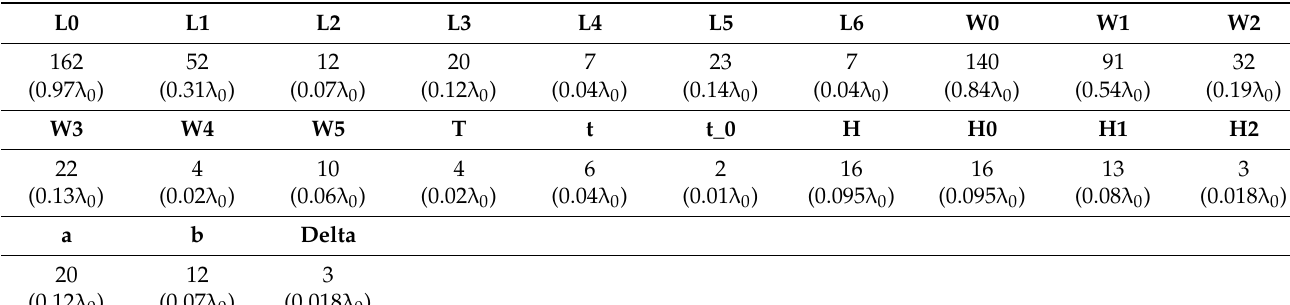
Figure 3. The structure of the proposed low-profile ME dipole. ( a ) Front view, ( b ) top view, ( c ) bended fixing structure, ( d ) feeding line. Table 1. Parameter size of the low-profile ME dipole antenna (unit: mm).